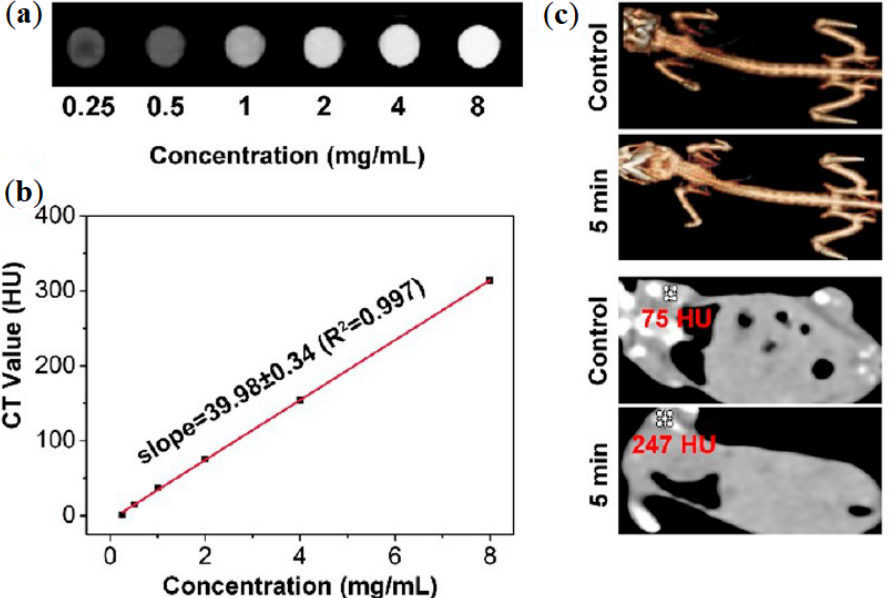
Figure 4. ( a ) In vitro results from CT using GZUC-PEG at several concentrations. ( b ) CT value of GZUC-PEG dispersed in aqueous solutions at several concentrations. ( c ) CT imaging and 3D ren- derings of CT images of tumor-bearing mice without, i.e., control, and with GZUC-PEG. Reprinted with permission from ref. [45]. Copyright 2018 American Chemical